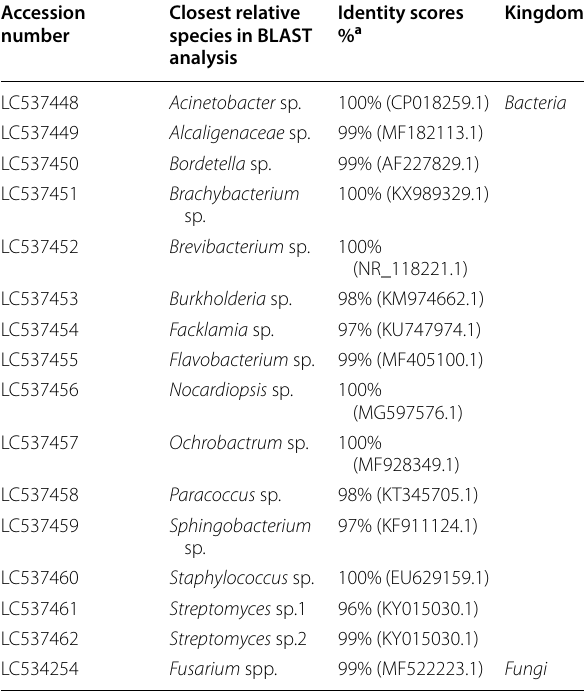
tional file 1: Table S1) and identified using the NCBI database (Table 2). Identified bacteria were